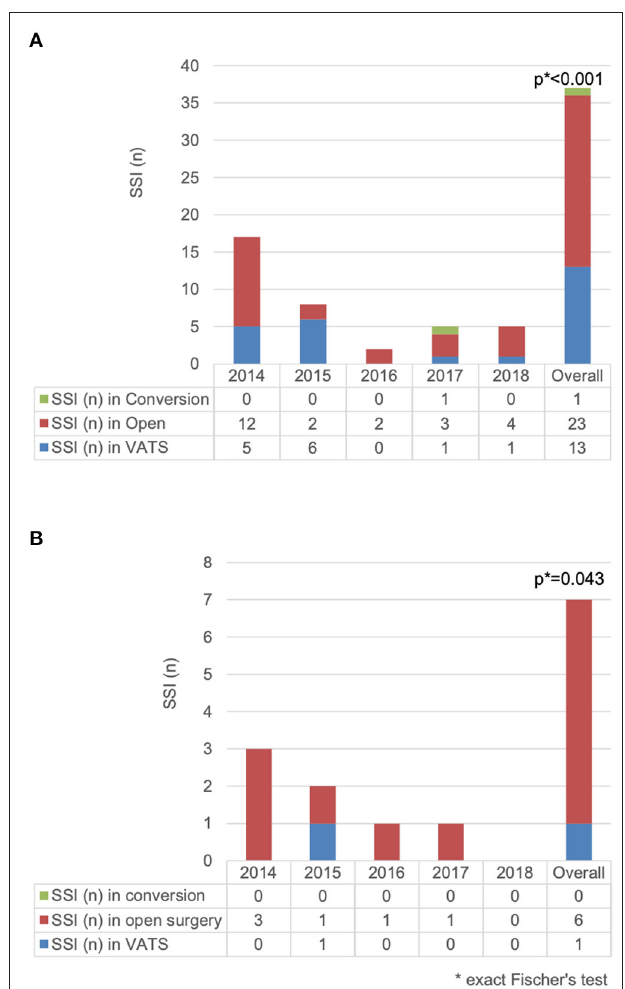
FIGURE 1 | Comparison of surgical site infection ( n ) for (A) 2,430 patients undergoing thoracic surgery and (B) 700 patients undergoing anatomical resection according to access type.